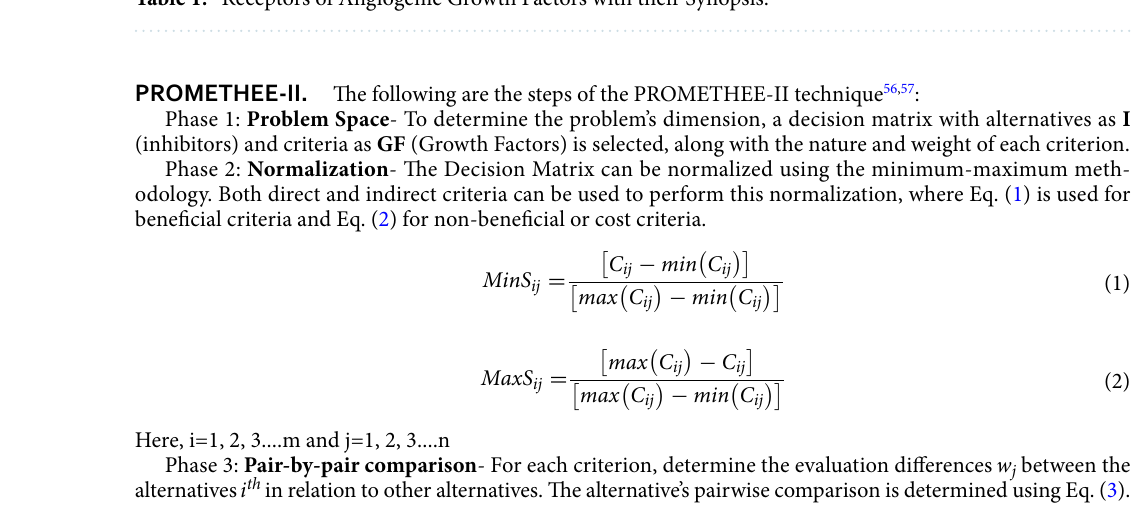
Table 1. Receptors of Angiogenic Growth Factors with their